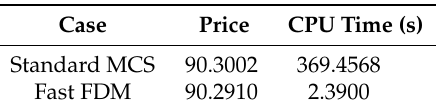
Table 1. The price and computation time of Type 1 ELS prices with the standard Monte Carlo simulation (MCS) and the fast finite difference method